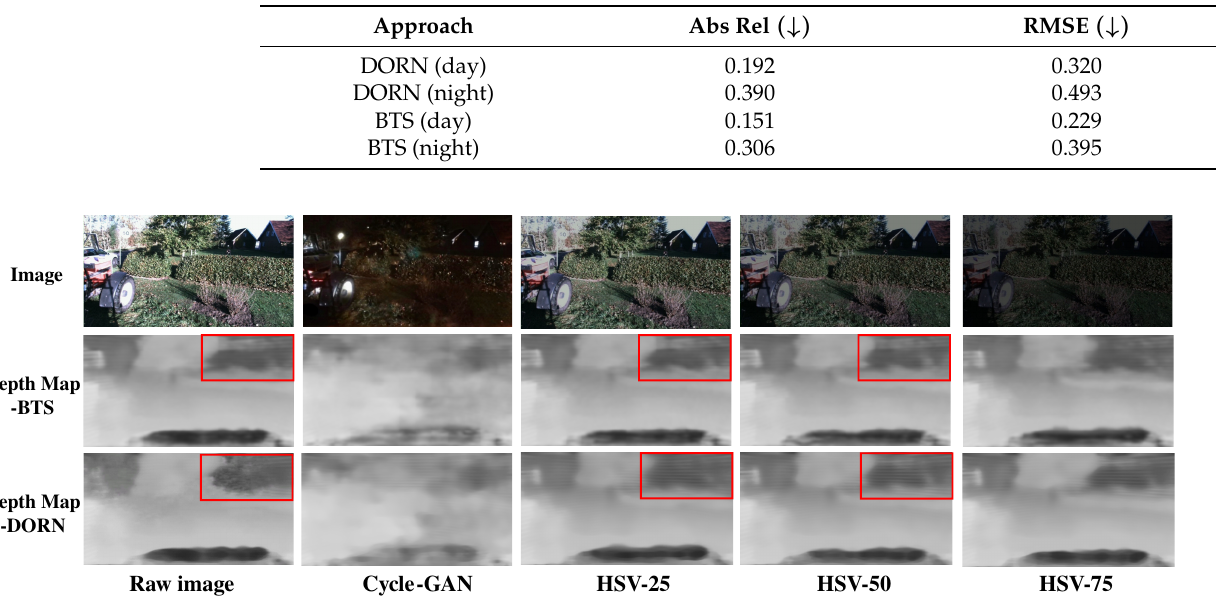
Figure 11. Depth estimation results of monocular RGB images. The bottom area of depth maps by BTS and DORN are mostly with value 0 due to the blind area of LiDAR and label design. Areas with significant differences of depths are displayed within red